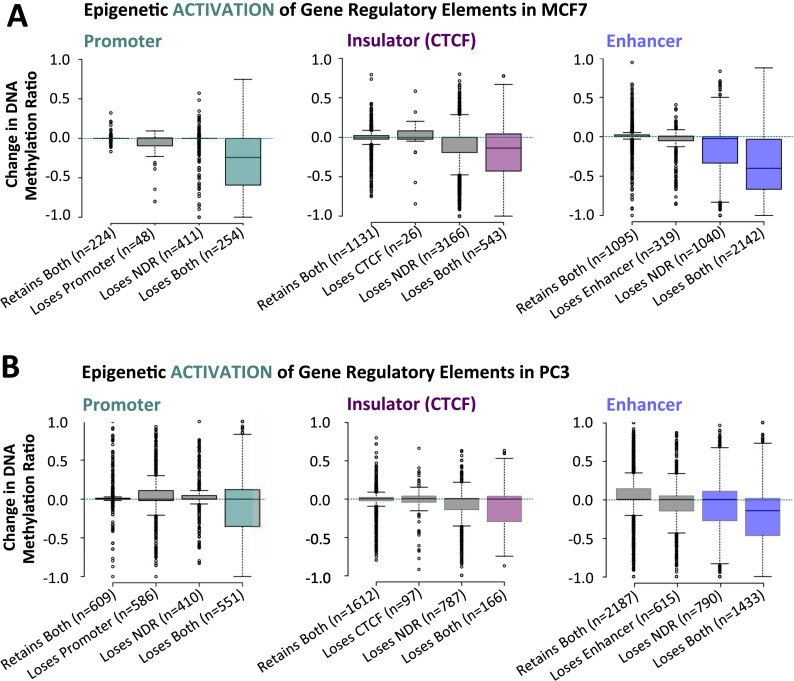
Epigenetic activation of enhancers and insulators, in addition to promoters, in cancer cells. (A) Promoters (broadly, nucleosome-depleted, and H3K4me3 enriched) were defined in MCF7 cells. These exact genomic regions were subject to ChromHMM classification in HMEC cells, and the extent and type of epigenetic activation (nucleosome loss, acquisition of active epigenetic marks, and reduced DNA methylation) was determined at promoters (left panel, teal). Similarly, for insulators (broadly, nucleosome-depleted, and CTCF; center panel, purple) and enhancers (broadly, nucleosome-depleted, and H3K4me1 enriched; right panel, blue). (B) As in A, for PrEC and PC3 cells.